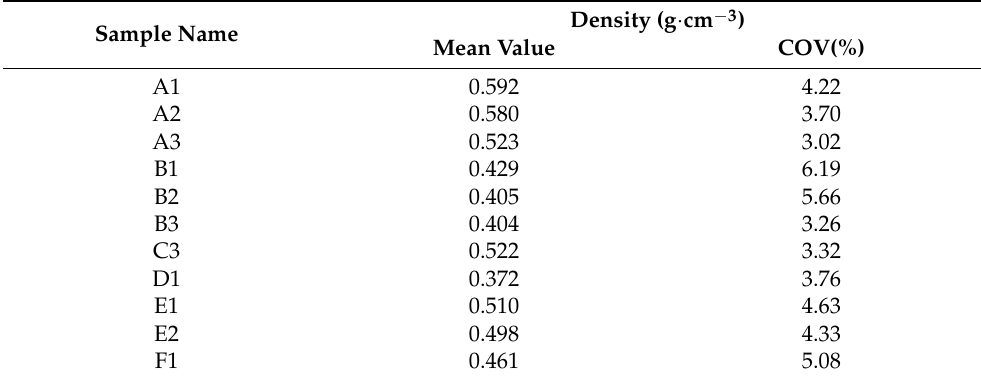
Table 2. Density of the